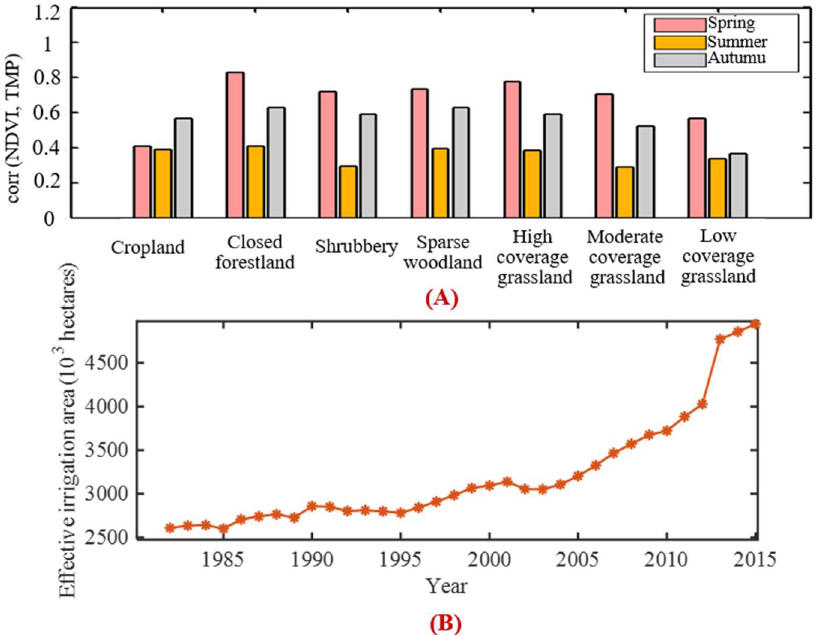
Figure 12. ( A ) The correlation between NDVI and TMP; ( B ) dynamic change of effective irrigated area in Xinjiang.